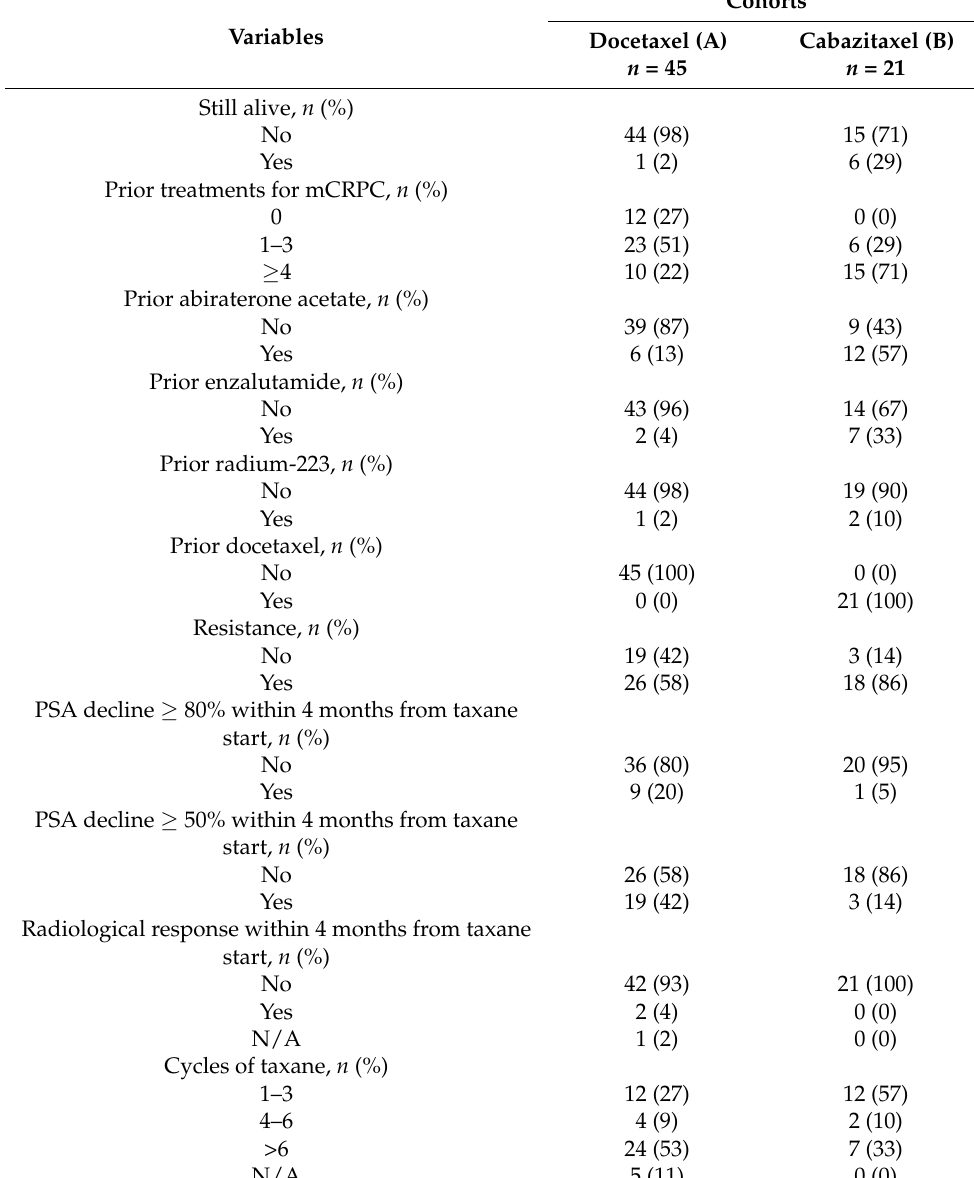
Table 1. Patient characteristics.